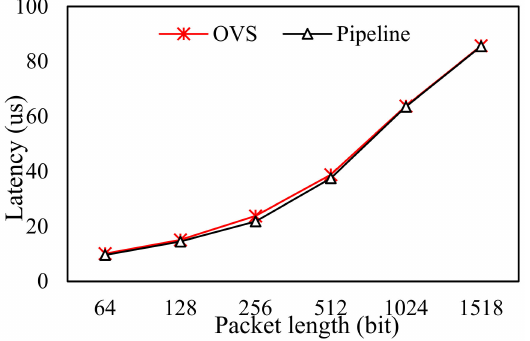
Figure 10. TTL modification and checksum computation are implemented via pipeline and OVS, respectively, with independent data loading and data loading linked with instructions. The difference in performance between the two data loading methods is reflected in packet forwarding